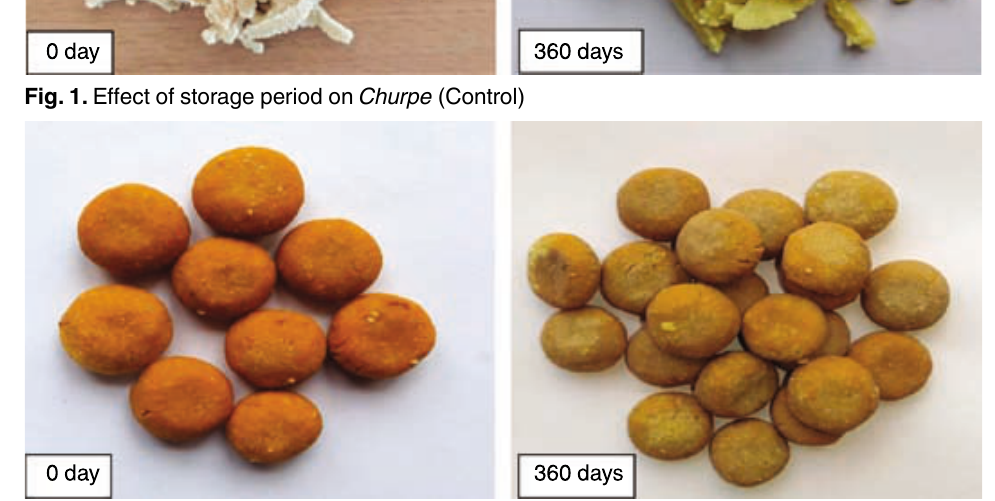
Fig. 2. Effect of storage period on Churpe -balls